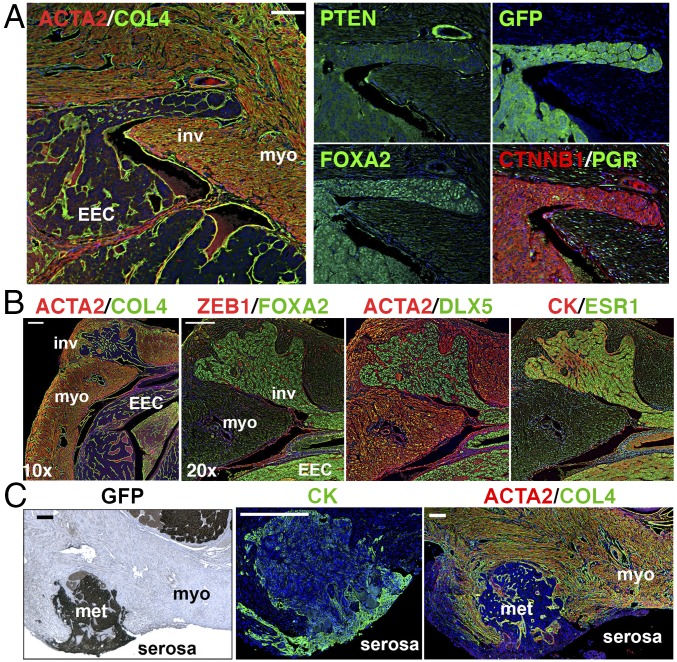
Characteristics of myoinvasive lesions and serosal metastasis. (A) Myometrial invasion of EECs at 8 wk after mutagenesis. The myoinvasion (inv) was continuous with EECs within endometrium, enclosed in a continuous basement membrane highlighted by collagen IV (COL4). IF for PTEN, EGFP, and FOXA2 indicated invasive lesions were triple-gene mutant. EECs were negative for PGR. (B) Expression profile of transcription factors (FOXA2, DLX5, and ESR1) was identical between invasive lesions and EECs within endometrium. (C) Serosal metastasis. Metastatic EEC (met) expressing GFP and CK penetrated the myometrium (myo, ACTA2 positive) and reached the uterine serosa. (Scale bars: A and C, 100 μm; B, 200 μm.)